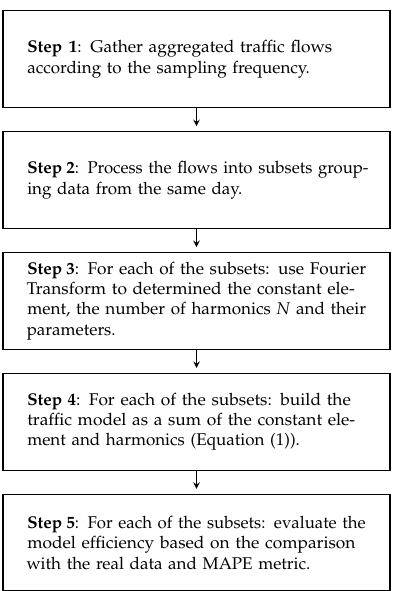
Figure 7. Traffic modeling–the methodology.